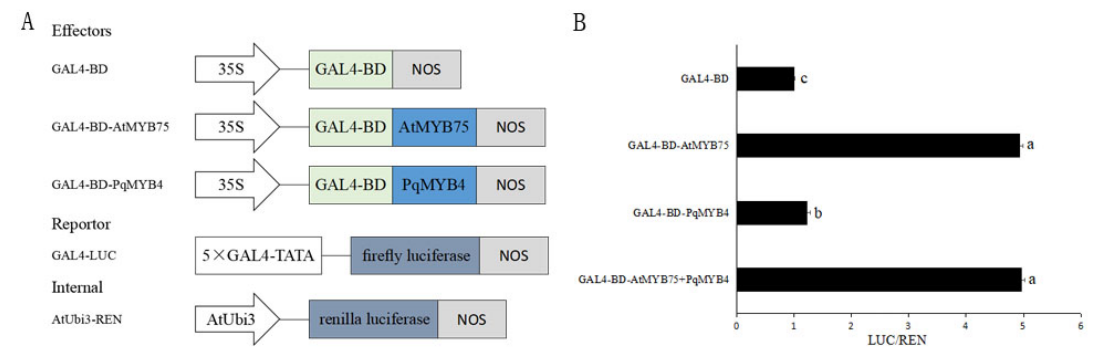
Figure 7. Dual Luciferase Transient Transfection Assay of PqMYB4. ( A ) scheme of the constructs used in the Arabidopsis protoplast cotransfection assay; ( B ) the relative luciferase activity (LUC/REN). a, b and c indicate significant difference at p ≤ 0.05 level by Duncan test.